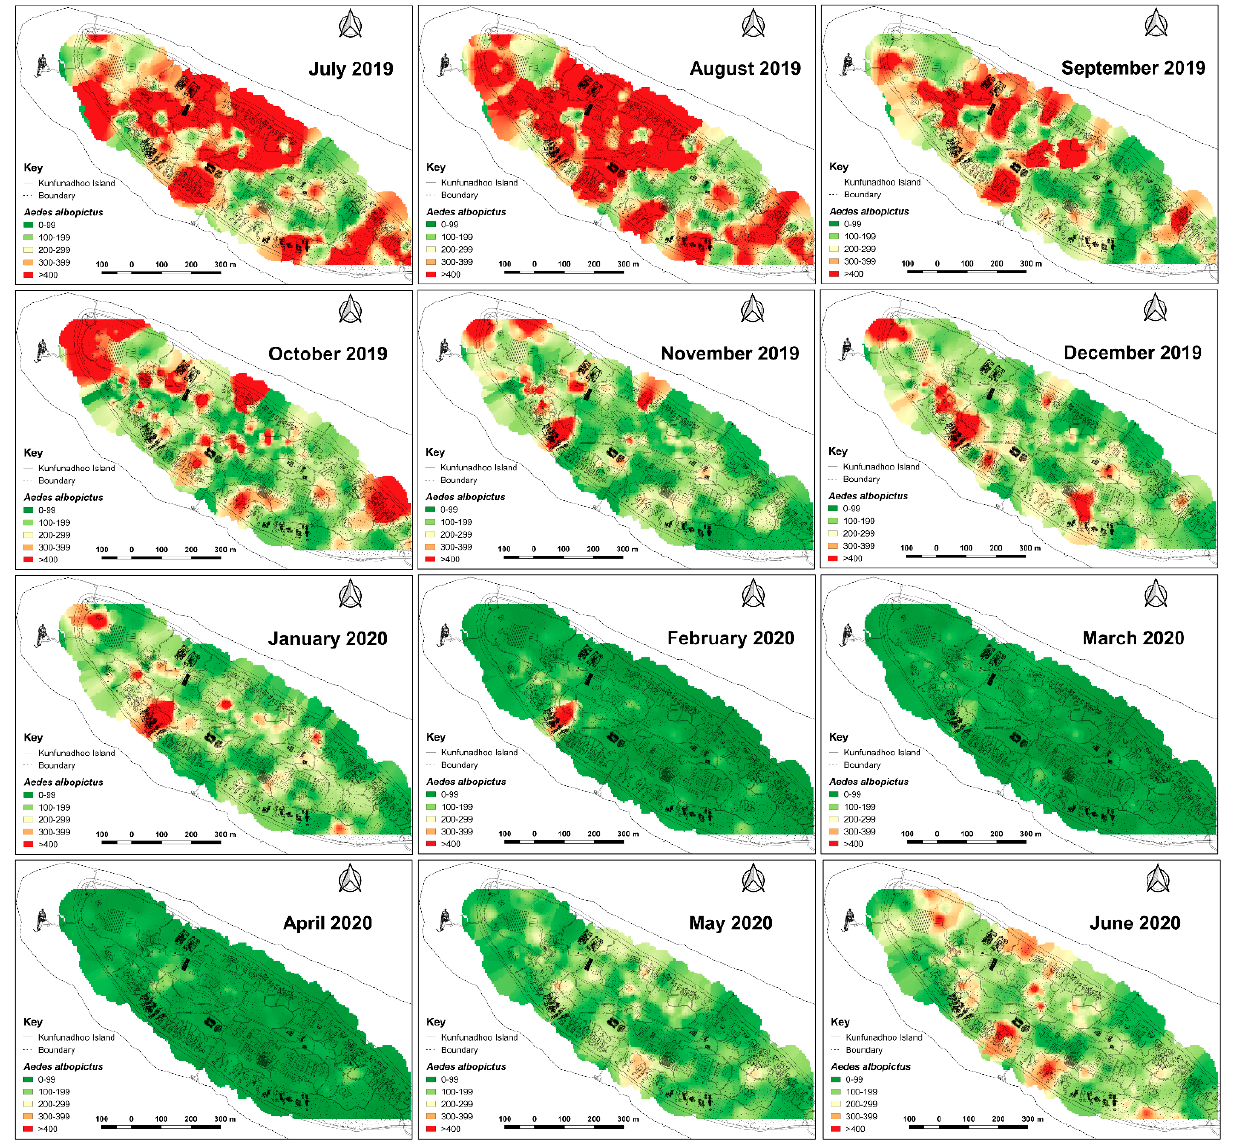
Figure 7. Inverse distance weighted heatmaps of Aedes albopictus showing areas with high (red) or low (green) mosquito catches by month for the period June 2019–June 2020. Following the first three months, with high densities across the northern part of the island, more discrete foci with high numbers emerged from October 2019 onwards, eventually resulting in very low numbers during the peak of the dry season (April 2020). Thereafter, notably in June, numbers increased when maintenance of potential breeding sites such as pools and ponds was temporarily suspended (due to COVID-19).